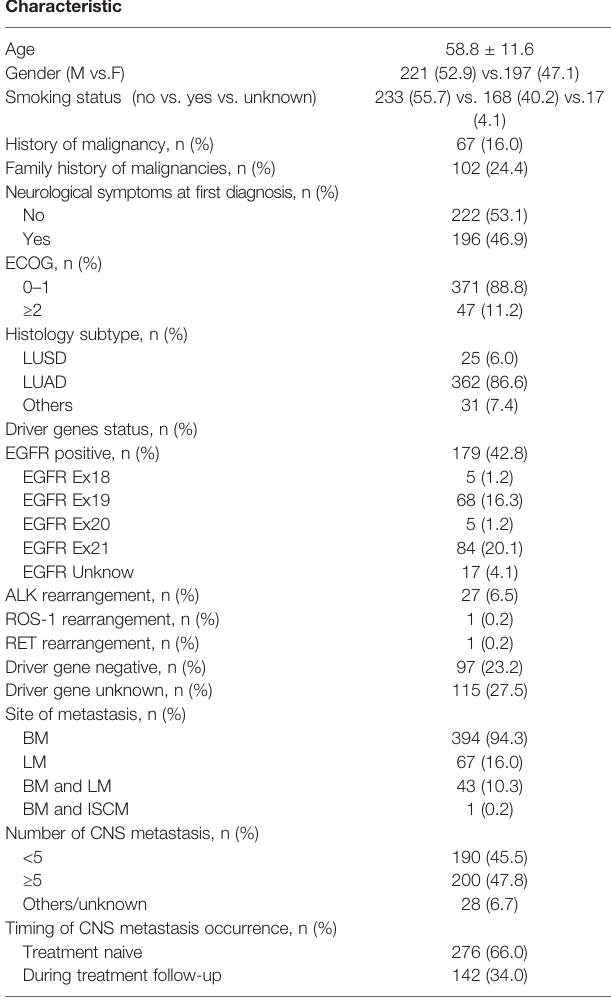
TABLE 1 | Clinical features of NSCLC patients with CNS metastases.